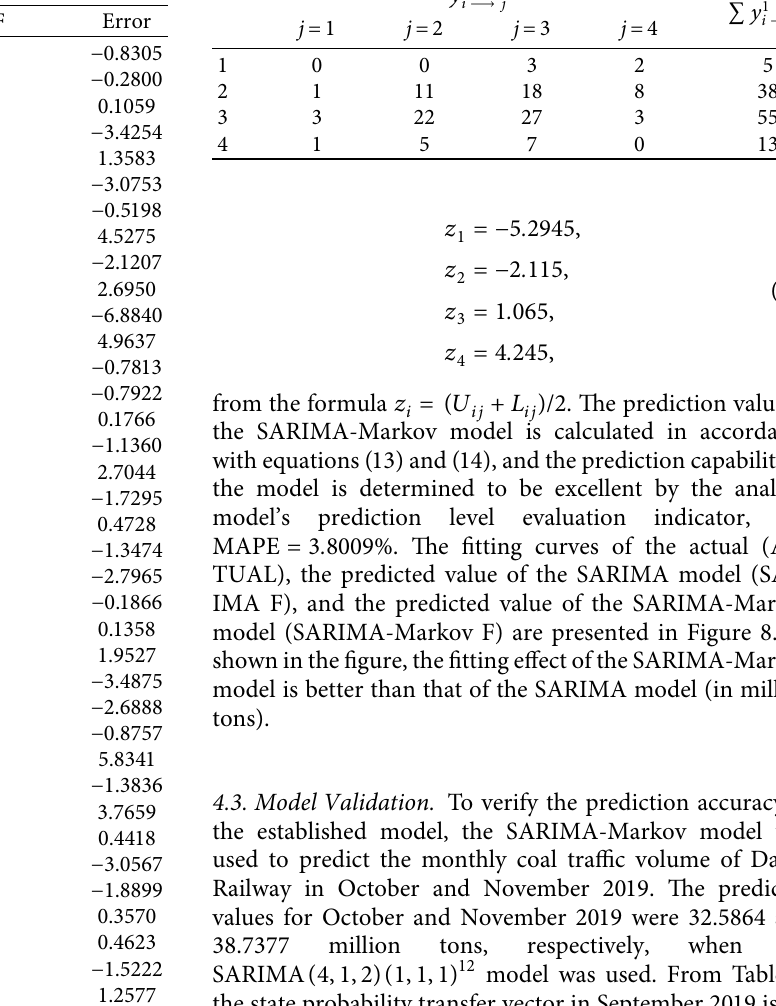
Table 3: Statistical table of the SARIMA model’s predicted value and residual sequence (in million tons).